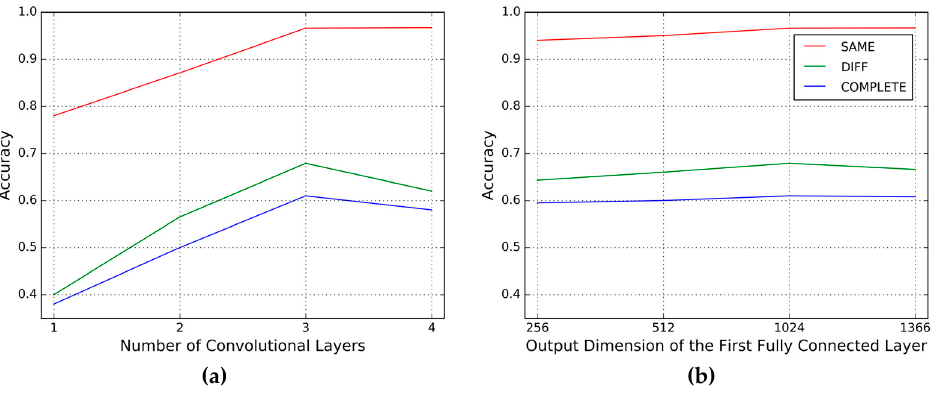
Figure 9. Evaluation for the hyperparameters of the CNN: ( a ) performance on different numbers of convolutional layers; ( b ) performance on different output dimension of the first fully connected layer.